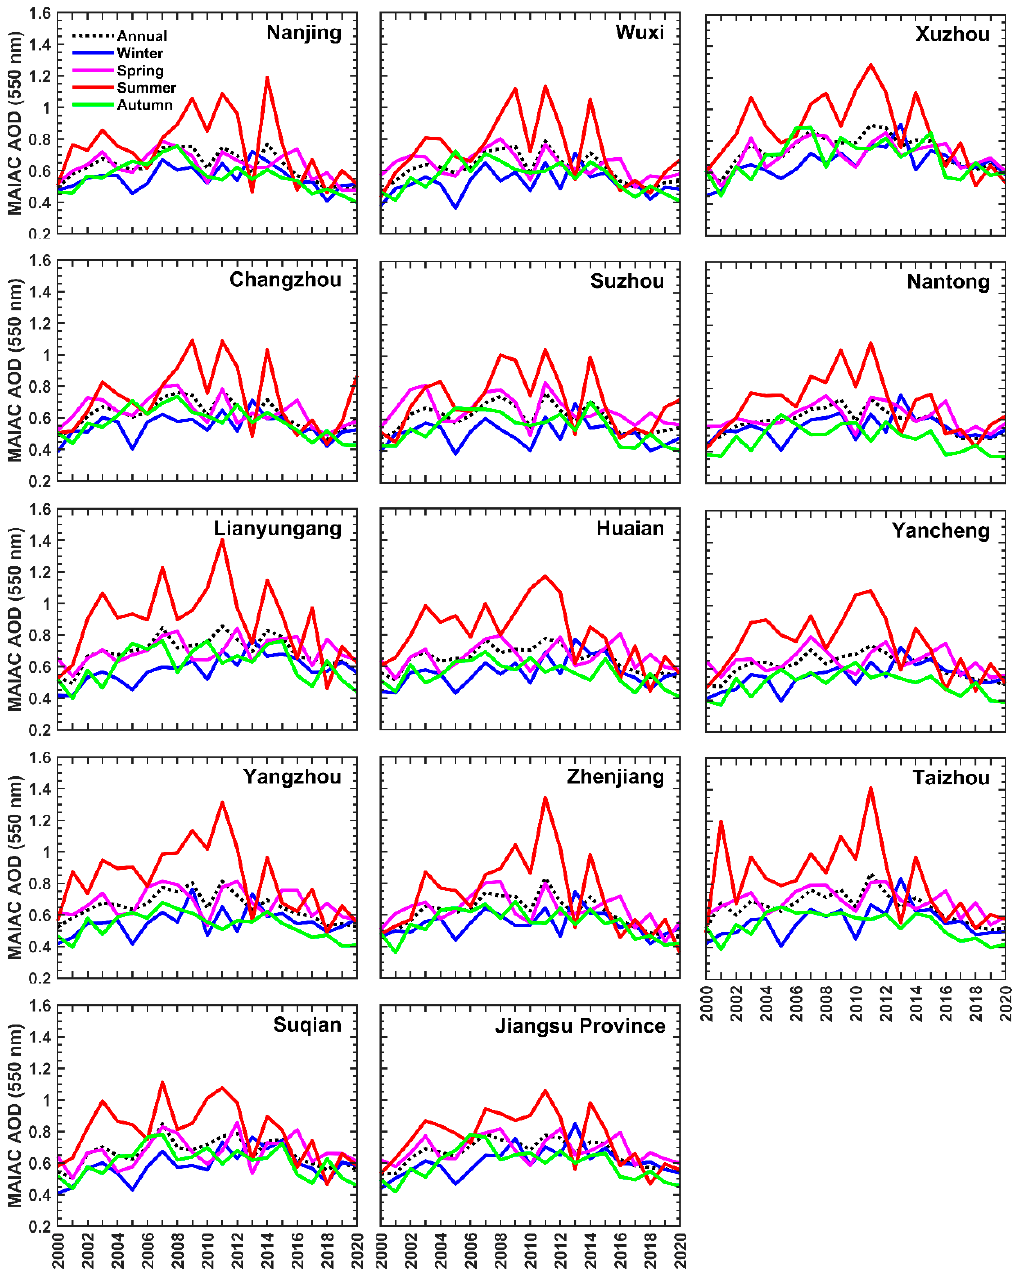
Figure 4. Annual and seasonal variations of high-resolution MODIS MAIAC AOD in 13 cities in Jiangsu Province from 2000 to 2020.